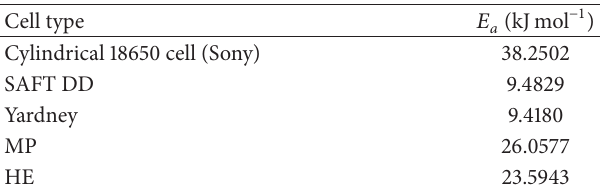
Table 4: Reaction activation energies for different battery systems.